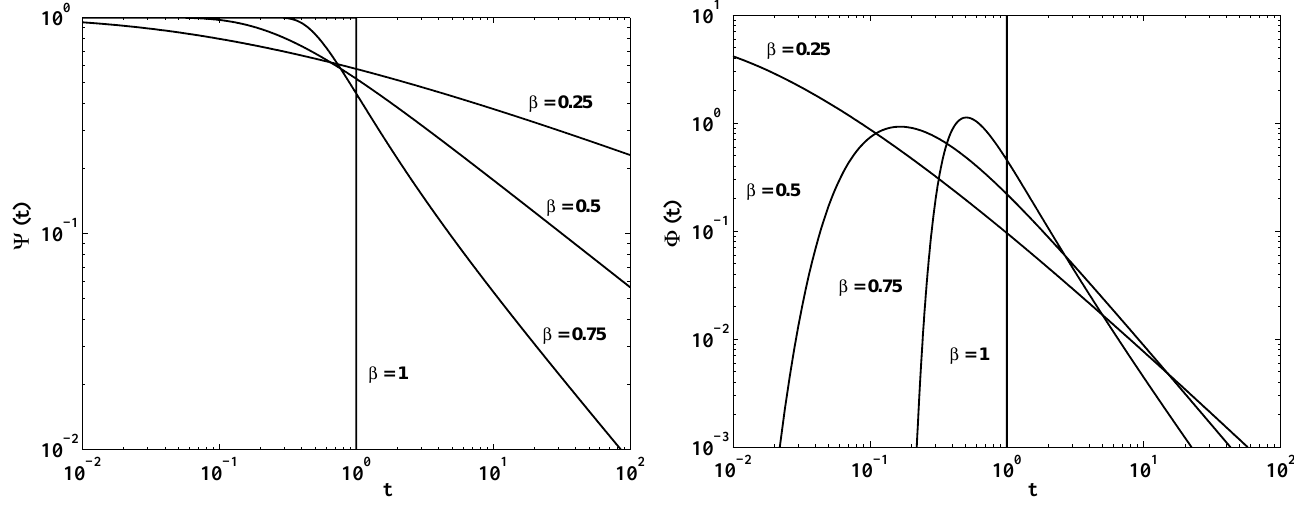
Figure 2. The functions Ψ( t ) ( left ) and φ ( t ) ( right ) versus t ( 10 − 2 < t < 10 2 ) for the renewal processes of Wright type with β = 0 . 25 , 0 . 50 , 0 . 75 , 1 . For β = 1 the reader would recognize the Box function (extended up to t = 1 ) at left and the delta function (centred in t = 1 ) at